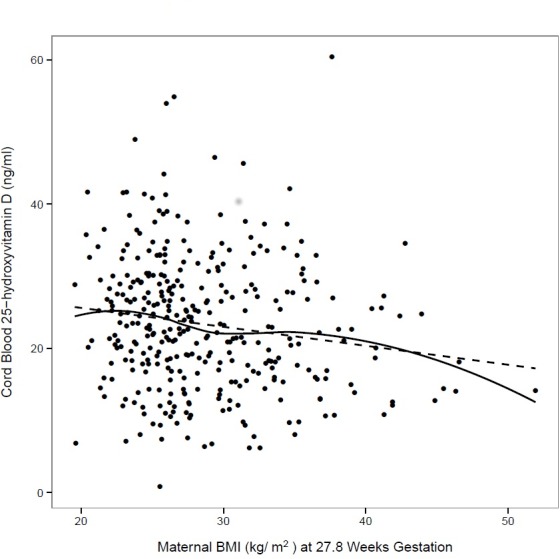
Maternal BMI versus Cord Blood 25-OHD Levels.Scatterplot of cord blood 25-hydroxyvitamin D versus maternal BMI measured at OGTT, N = 360. Both the regression line (dotted line, β estimate = -0.26) and loess curve demonstrate the inverse association between these two variables.